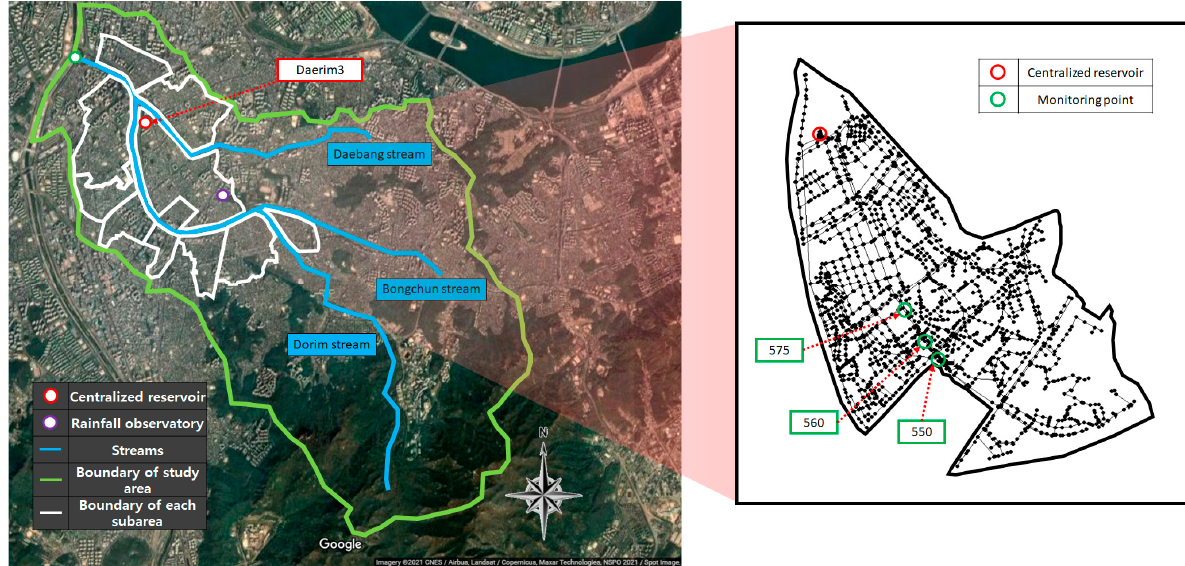
Figure 5. Location of study area and network of SWMM.